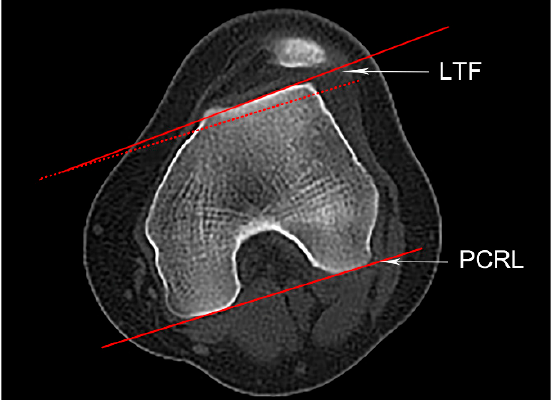
Figure 2. Lateral trochlea inclination (LTI). An axial slice showing an intact “Roman Arch” and the femoral condyles. The posterior condylar reference line (PCRL), its parallel line (the red dotted line), and a tangent line of the lateral trochlear facet (LTF) are shown. The LTI is defined as the angle between the PCRL and the LTF.